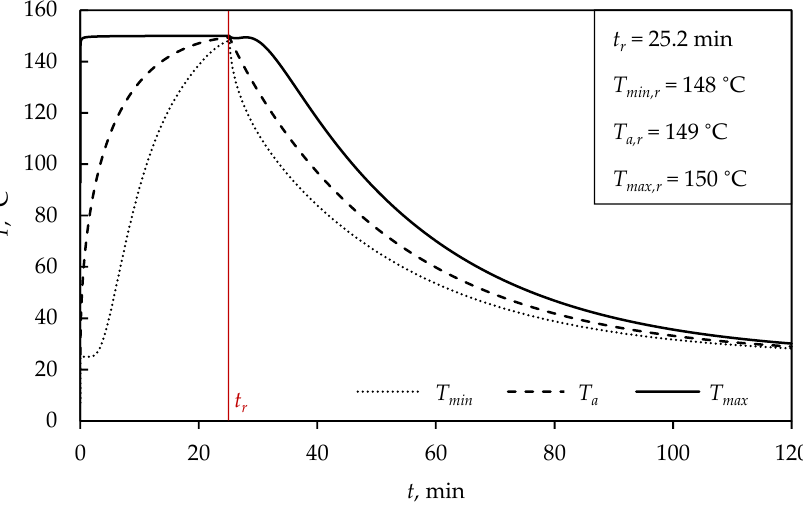
Figure 2. Dependence of product temperature on time for a sphere ( D = 5 cm) at T M = 150